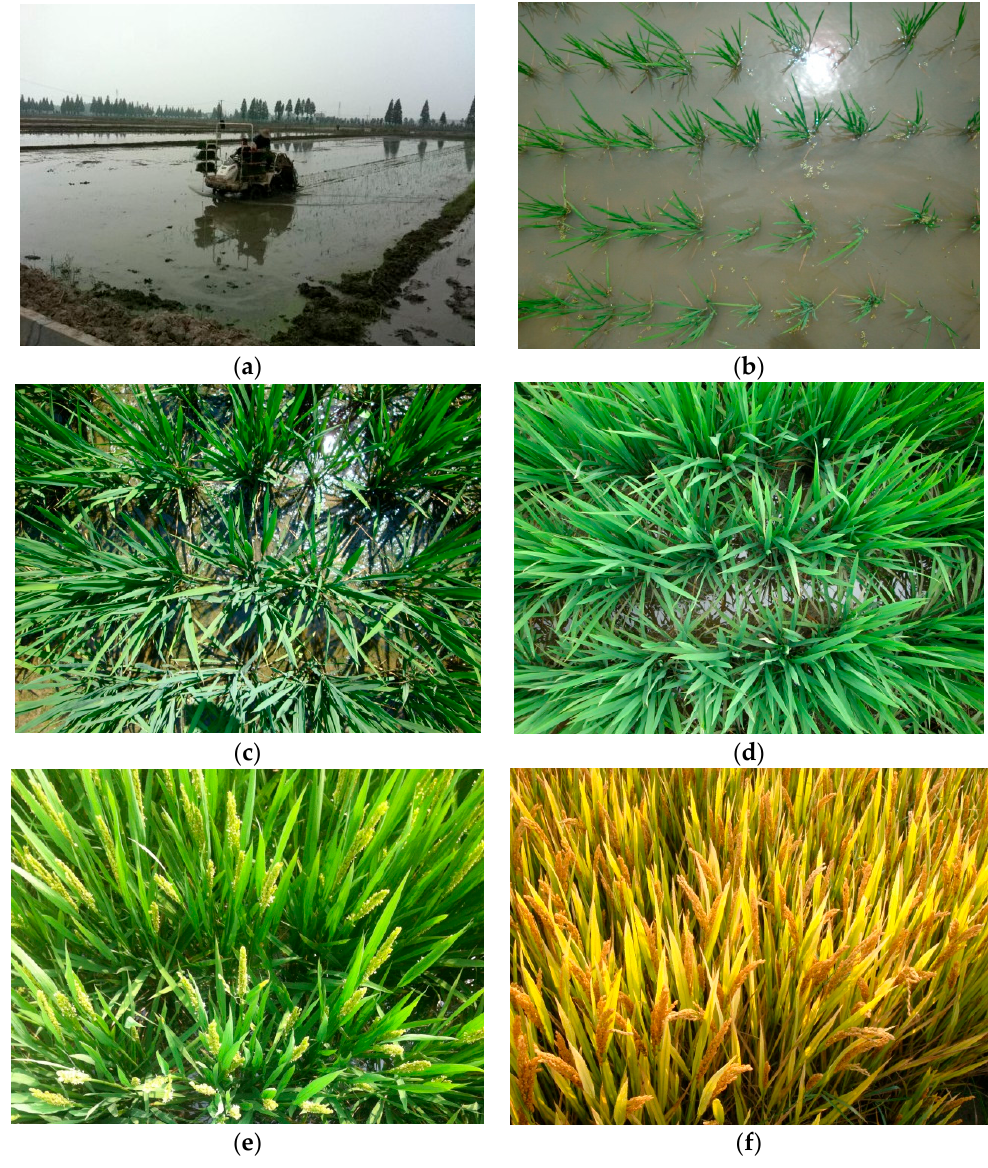
Figure 2. The single-cropped rice calendar in Deqing County, Zhejiang Province, China: ( a ) machinery transplants rice seedlings, 21 June 2012; ( b ) tillering period, about two weeks after transplanting; ( c ) the tillering period reached the maximum tiller number on 30 July 2012; ( d ) ear differentiation period, 15 August 2012; ( e ) heading period, flowering, 31 August 2012; ( f ) ripening stage, ready to be harvested, 18 November 2012. Photos ( a – f ) were taken at the same rice sample plot, as there were several rice varieties planted, but the start date of each period is